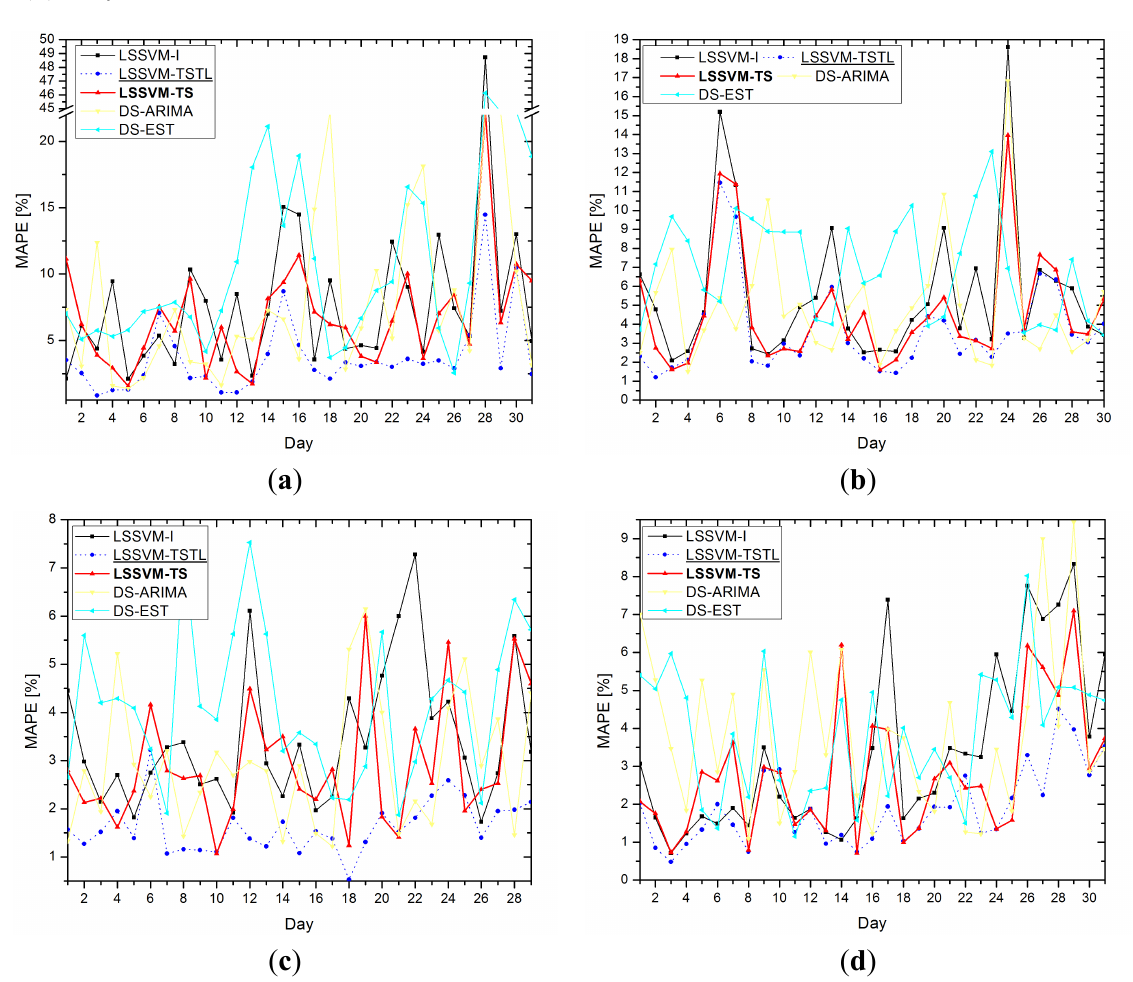
Figure 7. Daily MAPEs for all of STLF models. ( a ) August; ( b ) November; ( c ) February; ( d )